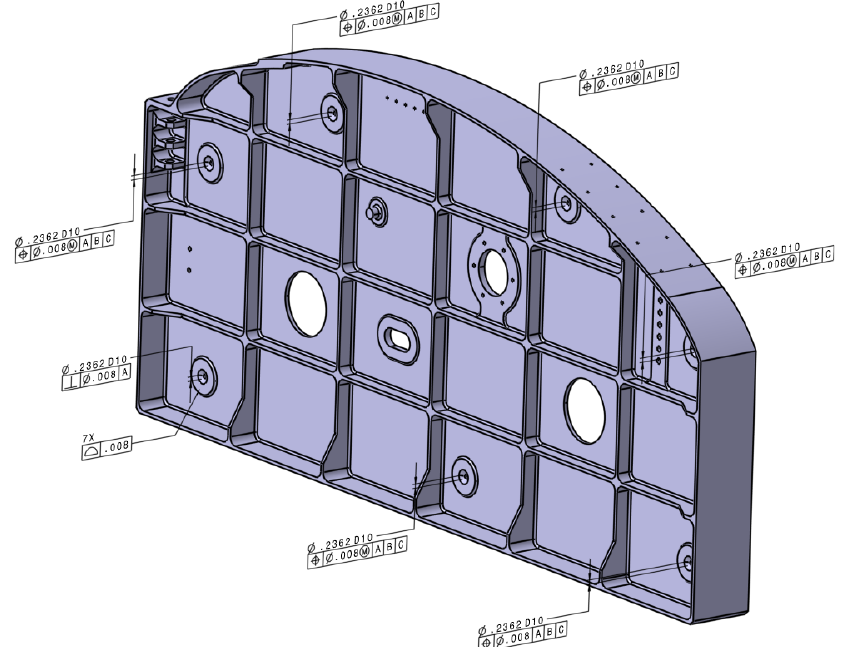
Figure A1. Tooling interface in ISO model.